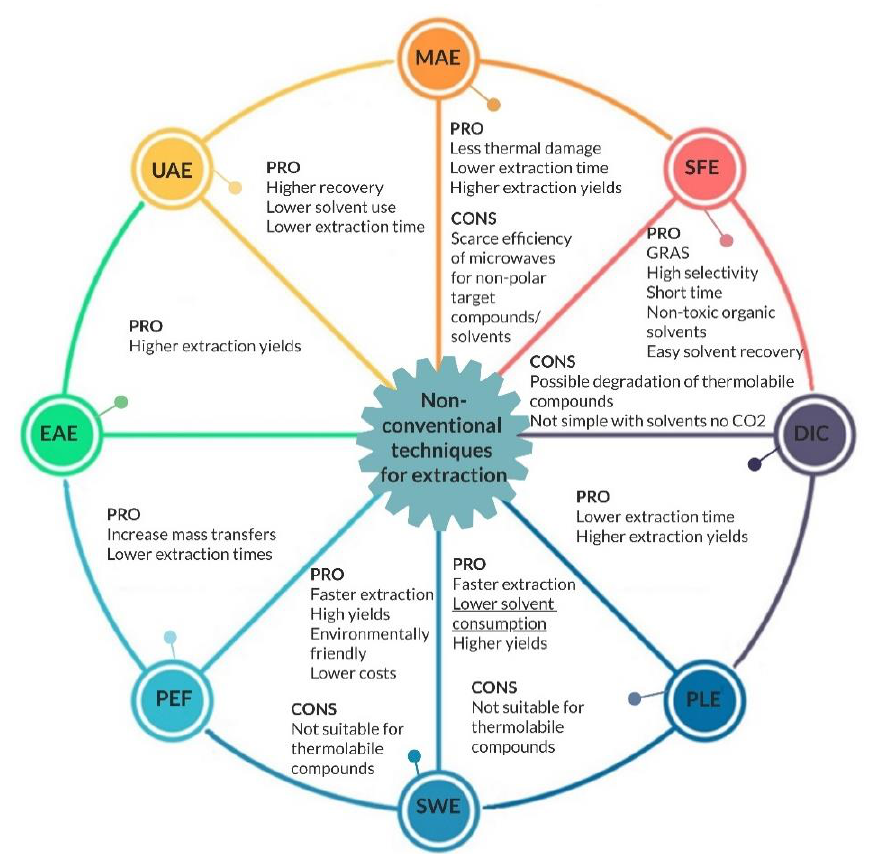
Figure 2. Operating principles of nonconventional techniques with their main advantages (PRO) and disadvantages (CONS) compared to traditional techniques. UAE, ultrasound-assisted extraction; MAE, microwave-assisted extraction; SFE, supercritical fluid extraction; DIC, instant controlled pressure drop-assisted extraction; PLE, pressurized liquid extraction; SWE, subcritical water extraction; PEF, pulsed electric field; EAE, enzyme-assisted extraction.